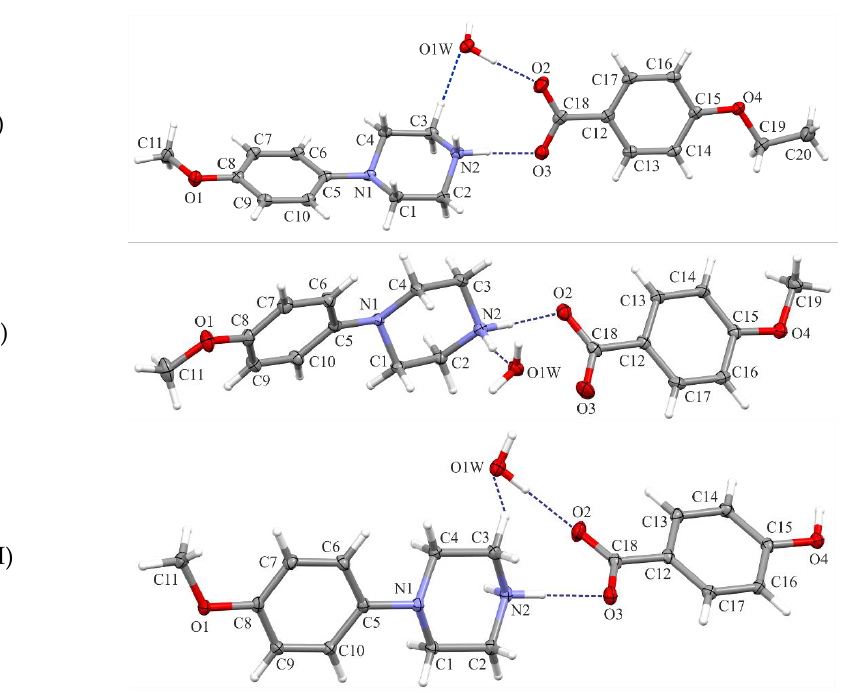
Figure 1. Views of the asymmetric units of the title structures (I) – (III), with the atom-numbering schemes. Displacement ellipsoids are drawn at the 30% probability level. H atoms are shown as spheres of arbitrary radius.